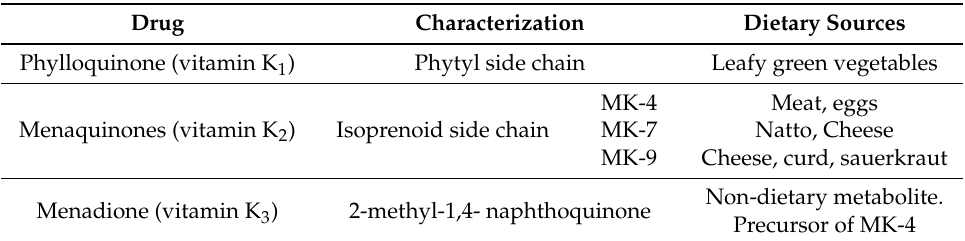
Table 1. Structural forms of vitamin